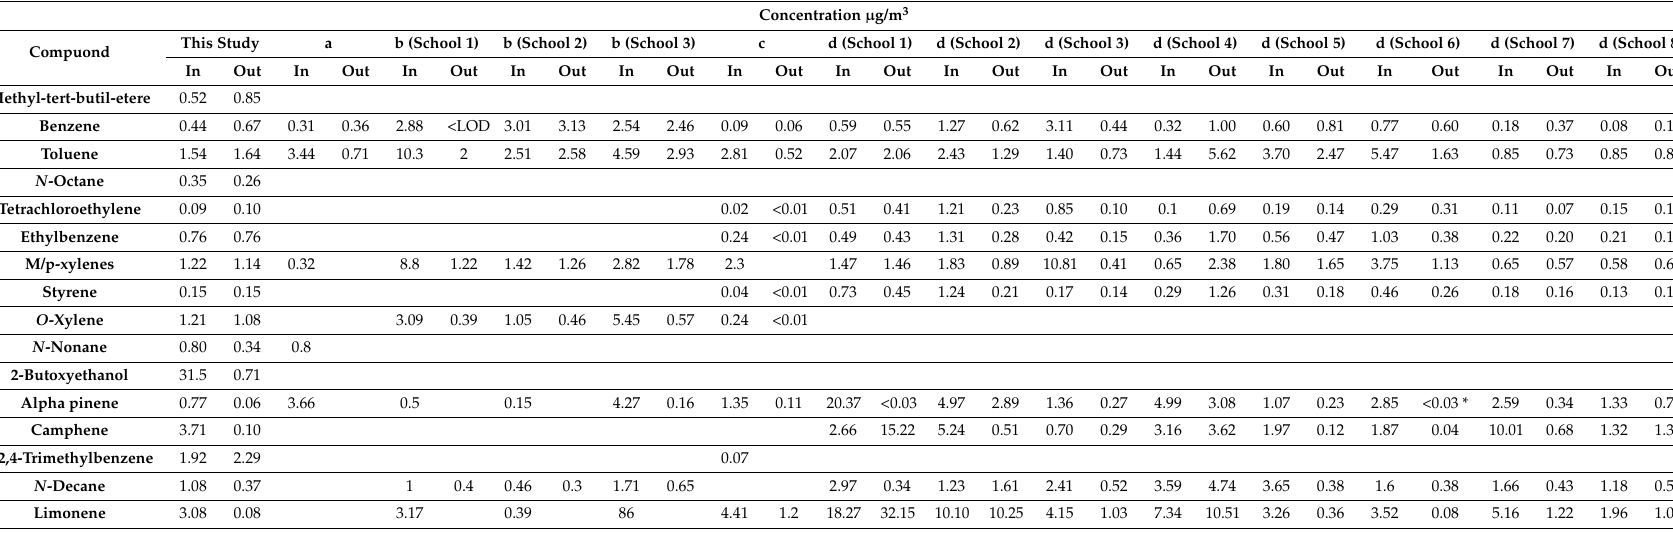
Table 2. Indoor school concentrations ( µ g/m 3 ) of selected VOC species in this, and in other studies. a = [11], b = [12], c = [13], d =